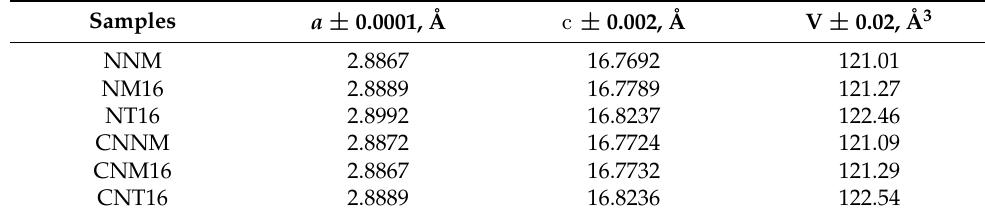
Table 1. Lattice parameters for Na 2/3 Ni 1/2 Mn 1/2 O 2 , Na 2/3 Ni 1/3 Mg 1/6 Mn 1/2 O 2 , Na 2/3 Ni 1/3 Ti 1/6 Mn 1/2 O 2 and their CeO 2 -treated